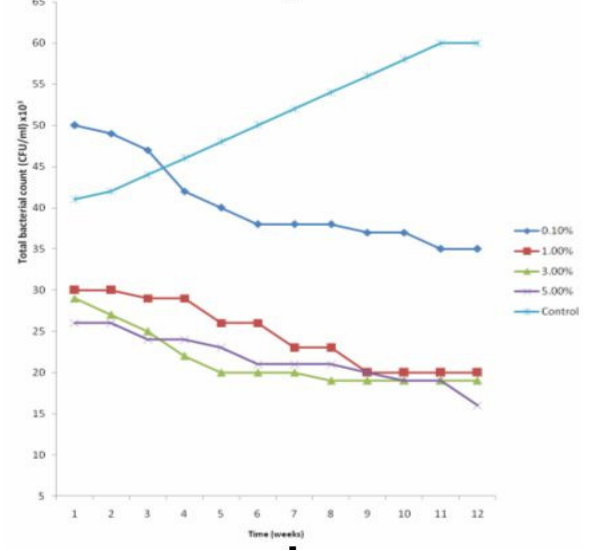
Fig. 3. Changes in the total bacterial counts of varying concentrations of sodium chloride preserved powder of mango seed kernels stored at room temperature for 12 weeks